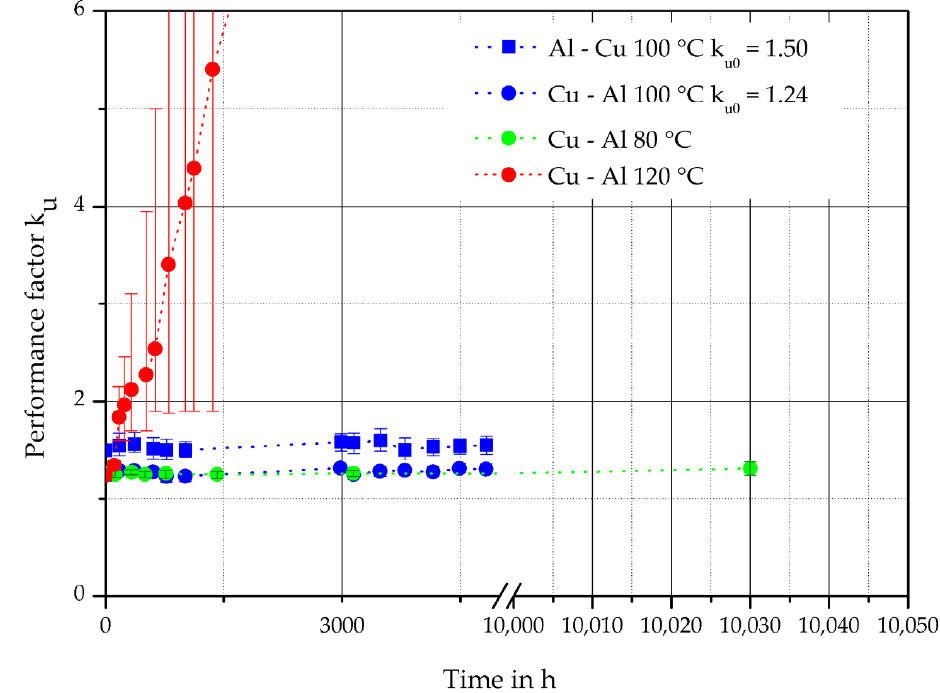
Figure 9. Performance factor k u of clinched connections with contact partners made of Cu-ETP and AlMg0.4Si1.2 as a function of time and temperature load .